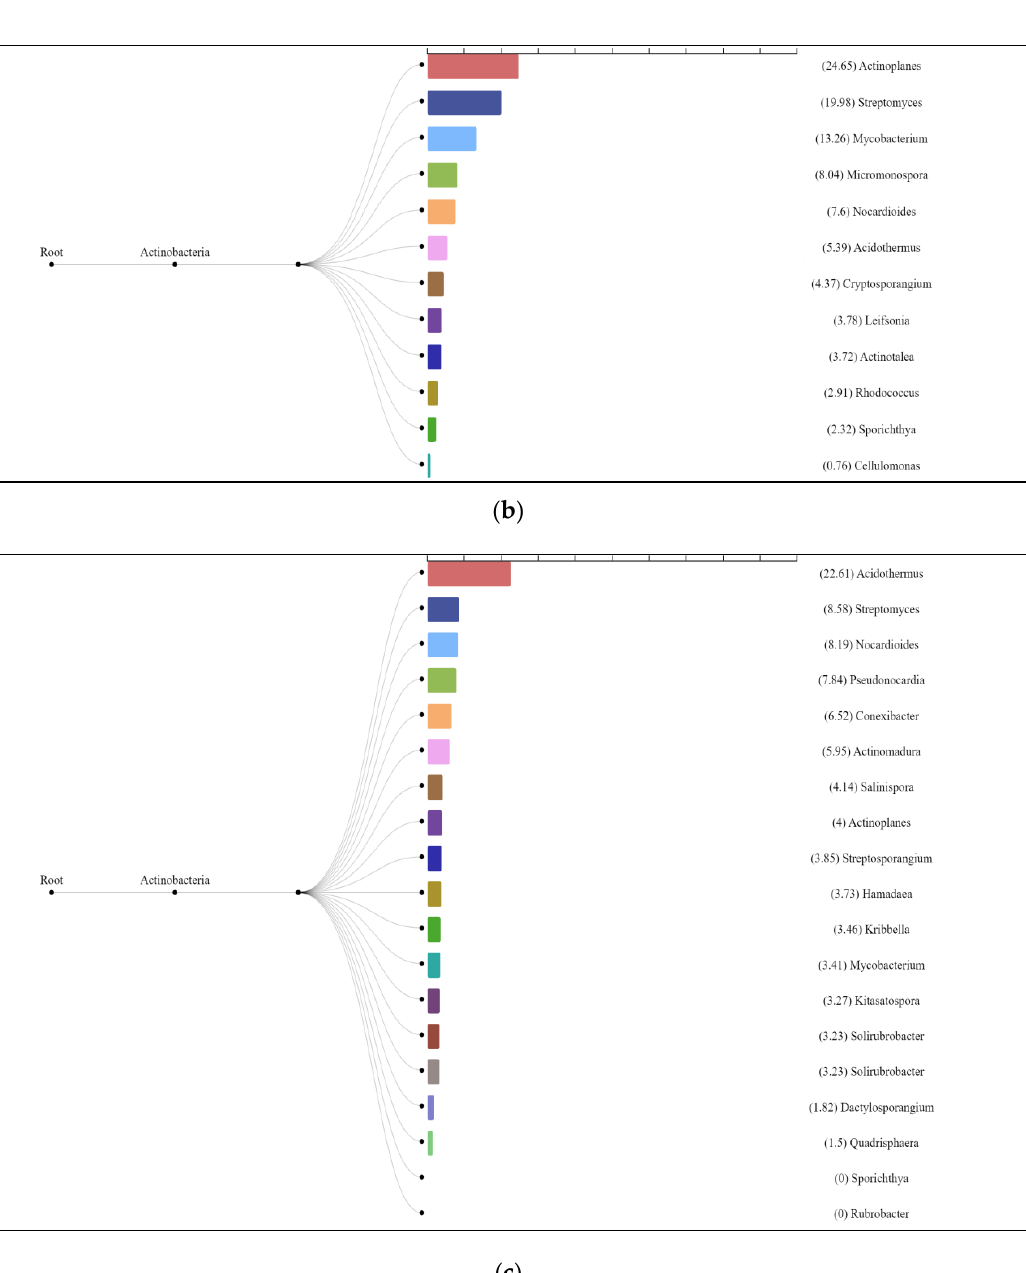
Figure 8. Dendrograms showing the contribution of bacteria of the Actinobacteriota phylum to the degradation cycle of starch and sucrose metabolism in samples of alluvial brown soil ( a ), leaf litter ( b ) and soil from epiphyte baskets ( c ) collected in the Pu Hoat Nature Reserve.